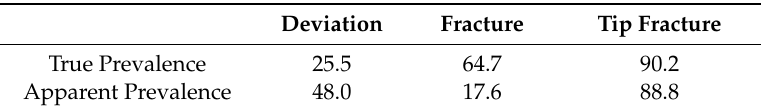
Table 1. The true prevalence of keel bone damage (% of total bones) as scored by keel bone dissection and the mean apparent prevalence on keel bone damage (% of total bones) as scored by palpation across four assessors.